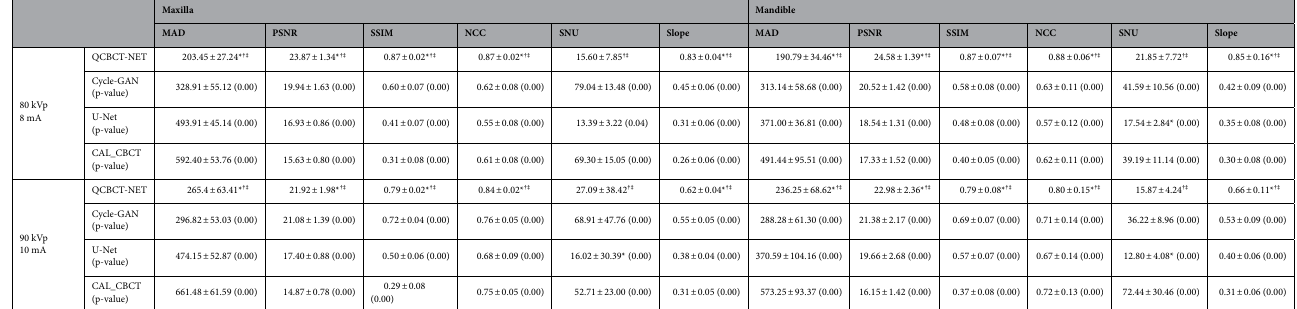
Table 1. Quantitative performance of CBCT images produced by QCBCT-NET, Cycle-GAN, U-Net, and CAL_CBCT compared to the original QCT images for measuring BMD values at the maxilla (1–81 slices) and mandible (82–200 slices) for test datasets under conditions of 80 kVp and 8 mA, and 90 kVp and 10 mA. MAD mean absolute difference, PSNR peak signal to noise ratio, SSIM structural similarity, NCC normalized cross correlation, SNU spatial nonuniformity, Slope slope of linear regression between the voxel intensities. Mean ± SD. *Significant difference ( p < 0.01) between QCBCT-NET and U-Net, † ( p < 0.01) between QCBCT- NET and Cycle-GAN, and ‡ ( p < 0.01) between QCBCT-NET and CAL_CBCT.